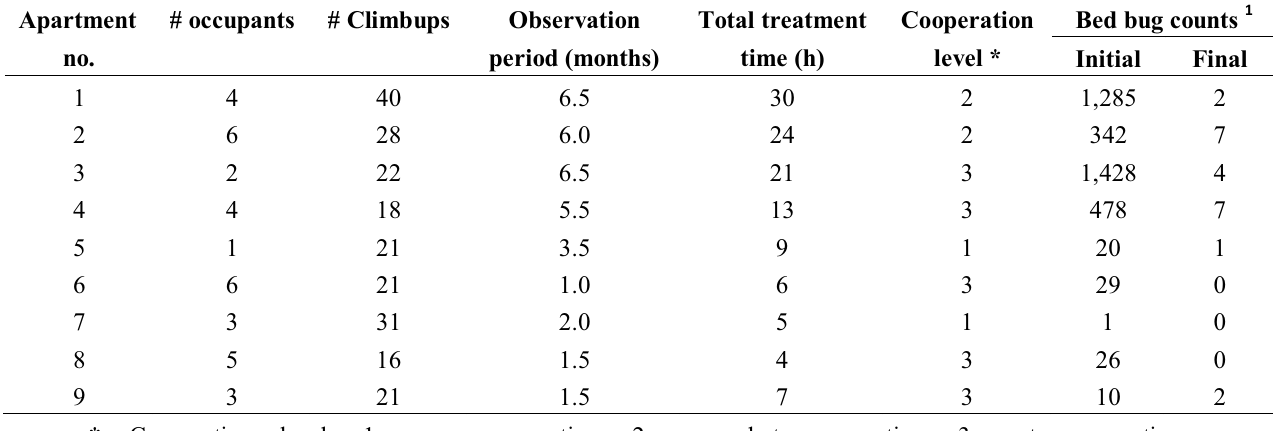
Table 1. Effectiveness of a bed bug management program at low-income housing